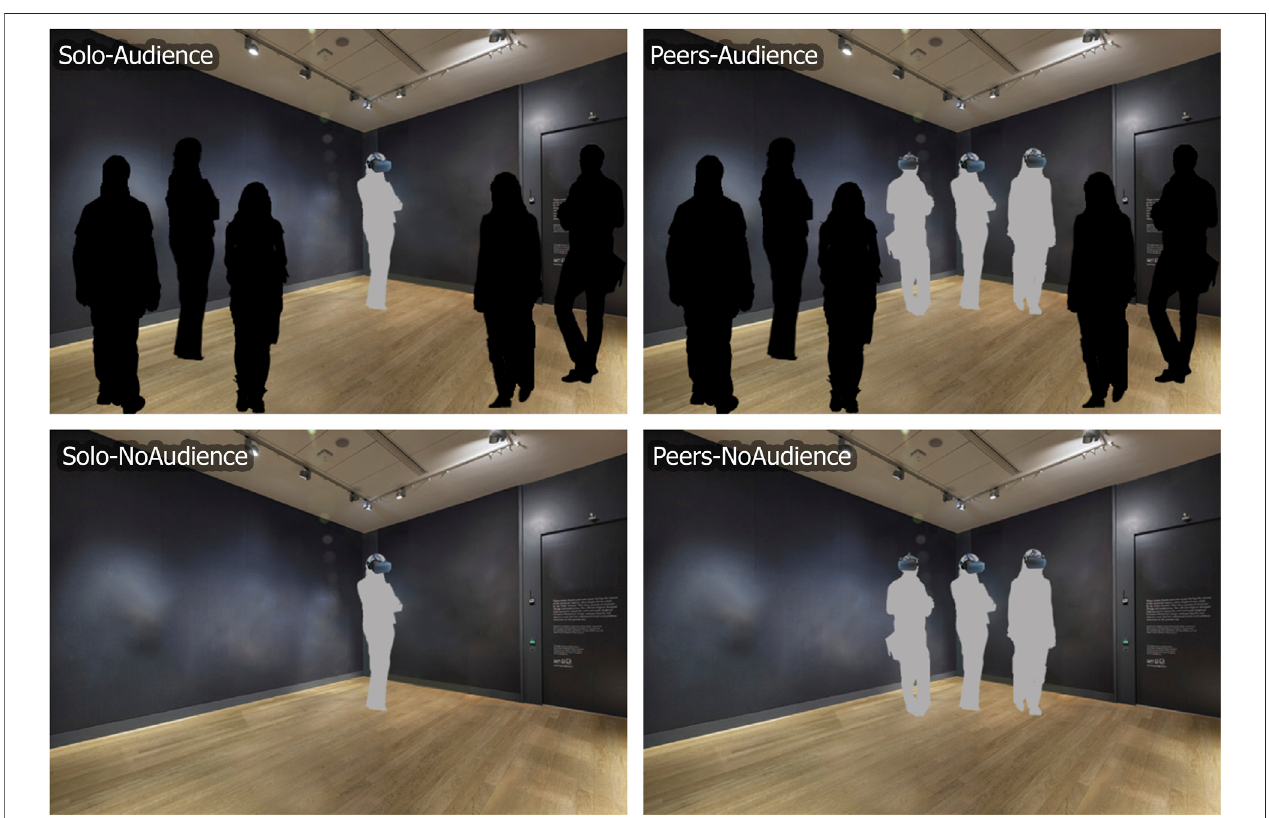
FIGURE 1 | An illustration of the four images used in the Anxiety and Willingness to Try trials.